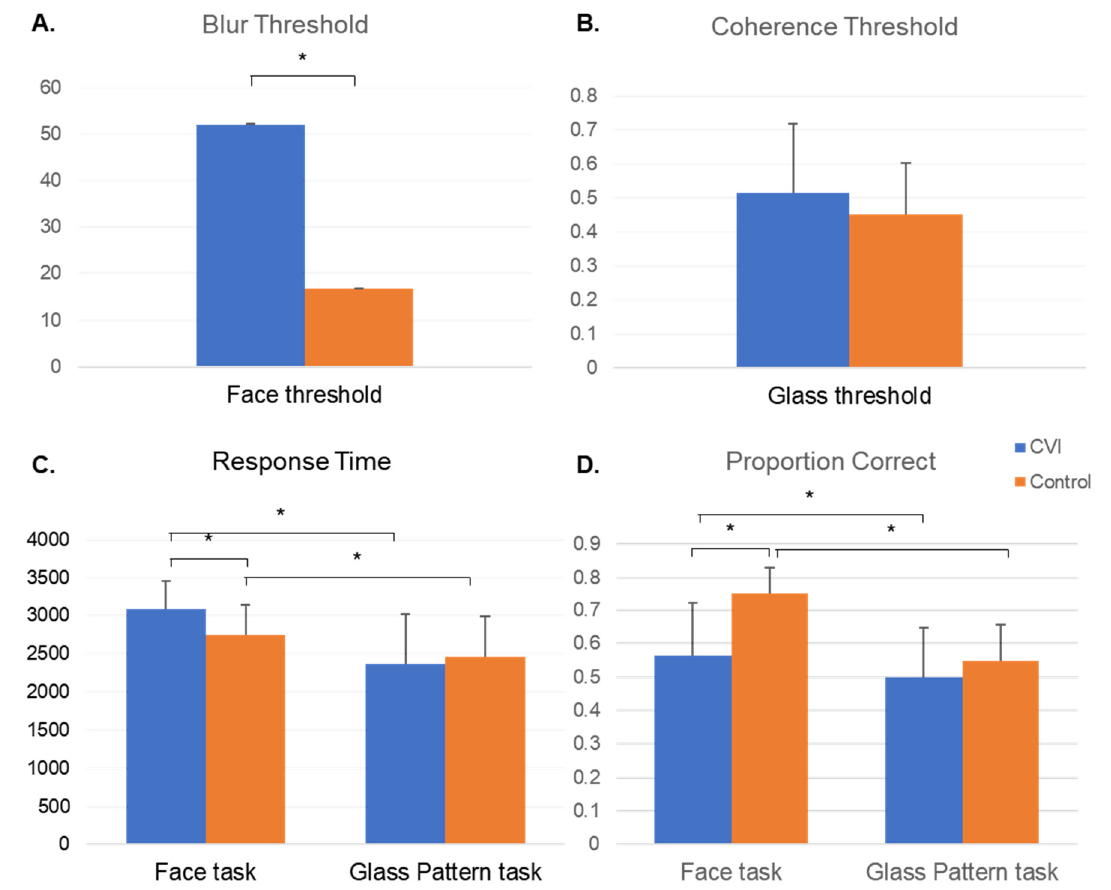
Figure 3. Mean (s.d.) results for ( A ) face threshold, ( B ) glass pattern threshold, ( C ) response time, and ( D ) proportion correct for the CVI (blue) and control (orange) groups. ( A ) The CVI group showed a significantly higher blur threshold for the face perception task, indicating that they were more susceptible to the effects of blur and required more clarity in order to perform the task and identify the matching face (i.e., higher threshold reflects worse performance). ( B ) Although the CVI group demonstrated a qualitatively higher threshold on the glass pattern task, this did not reach statistical significance ( p > 0.05). ( C ) The CVI group showed an increased response time compared to controls for the faces task, but not for the glass pattern task. Within each group, participants took longer to perform the face recognition task compared to the glass pattern task. ( D ) The CVI group achieved a lower proportion correct on both tasks compared to controls, but this only reached statistical significance for the face recognition task ( p < 0.0001). Within each group, participants achieved a higher proportion correct for the faces task compared to the glass pattern task ( p < 0.05 in both groups). * indicates p <